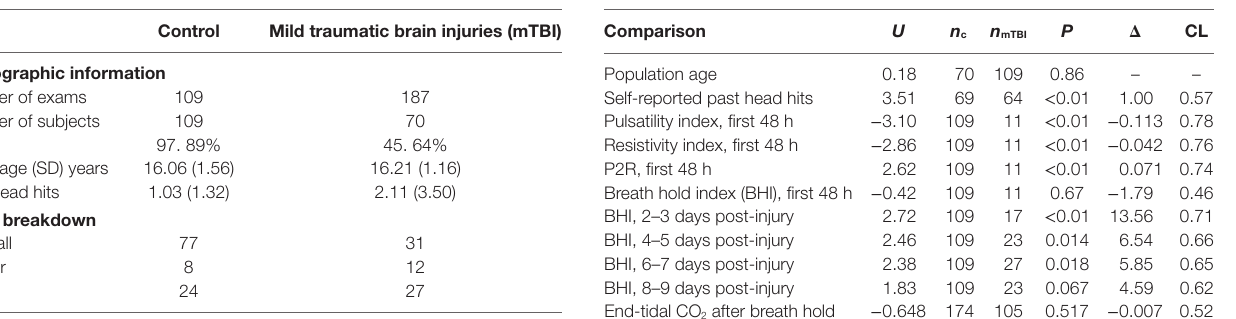
TaBle 2 | Statistical analysis of the presented results. TaBle 1 | Subject demographic and sport